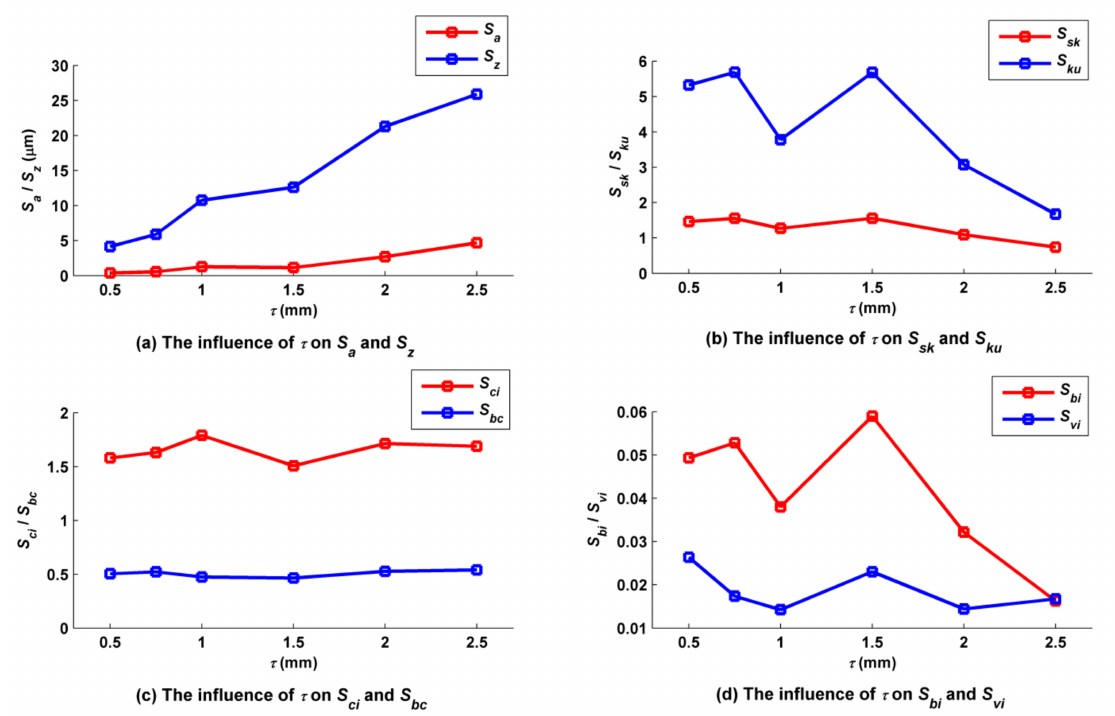
Figure 15. Influence of pitch on ball-end trochoidal milling surface